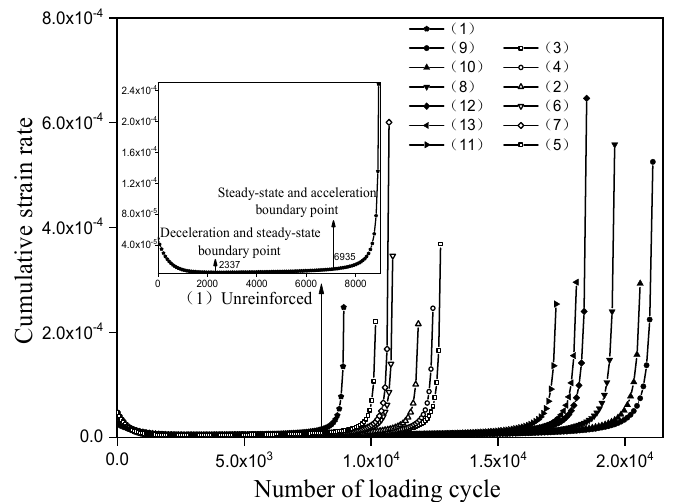
Figure 8. Cumulative strain rate under different reinforcement schemes.